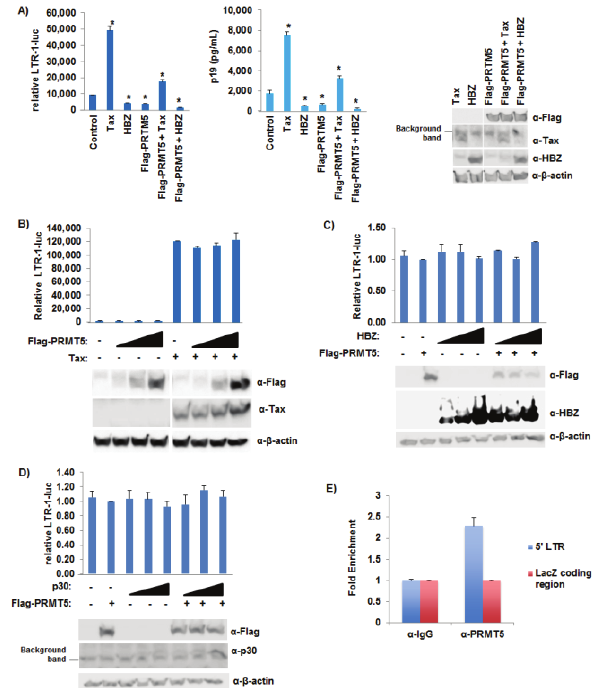
Figure 7. PRMT5 did not affect Tax transcriptional function. ( A ) HEK293T cells were transfected with 20 ng TK-renilla, 100 ng LTR-1-luciferase reporter, 1 μ g ACHneo, 100 ng S-tag-Tax, 500 ng S-tag-HBZ, and 500 ng flag-PRMT5 as indicated. Forty-eight hours post-transfection, cell lysates were collected and luciferase levels measured; relative luciferase activity for each condition is shown (left panel). The differences in relative LTR-1-luc activity compared to control were significant ( p < 0.05 (*)). HTLV-1 gene expression was quantified by the detection of the p19 Gag protein in the culture supernatant of each condition using ELISA (middle panel). The differences in p19 Gag levels compared to control were significant ( p < 0.05 (*)). Immunoblot analysis was performed to compare the levels of PRMT5 (Flag), Tax, HBZ, and β -actin (loading control) in each condition (right panel). All samples were analyzed on the same nitrocellulose membrane; ( B ) HEK293T cells were transfected with 20 ng TK-renilla, 100 ng LTR-1-luciferase reporter, 100 ng S-tag-Tax, and titrating amounts of flag-PRMT5 as indicated. Forty-eight hours post-transfection, cell lysates were collected, and luciferase levels measured; relative luciferase activity for each condition is shown (upper panel). Immunoblot analysis was performed to compare the levels of PRMT5 (Flag), Tax, and β -actin (loading control) in each condition (lower panel). All samples were analyzed on the same nitrocellulose membrane; ( C ) HEK293T cells were transfected with 20 ng TK-renilla, 100 ng LTR-1-luciferase reporter, 500 ng flag-PRMT5, and titrating amounts of HBZ as indicated. Forty-eight hours post-transfection, cell lysates were collected, and luciferase levels measured; relative